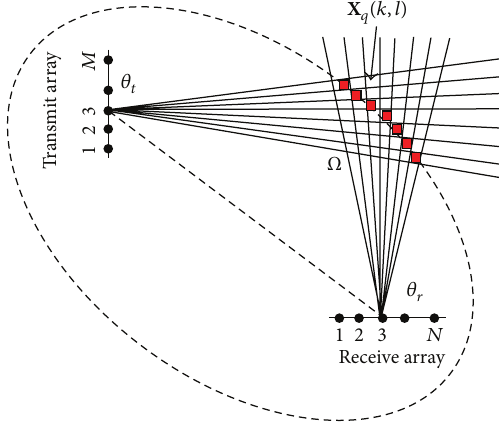
Figure 1: Bistatic MIMO radar